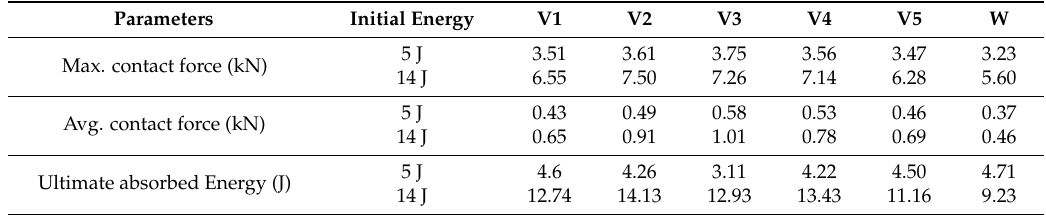
Table 4. The impact parameters of specimens of V1/V2/V3/V4/V5/W under the two impact